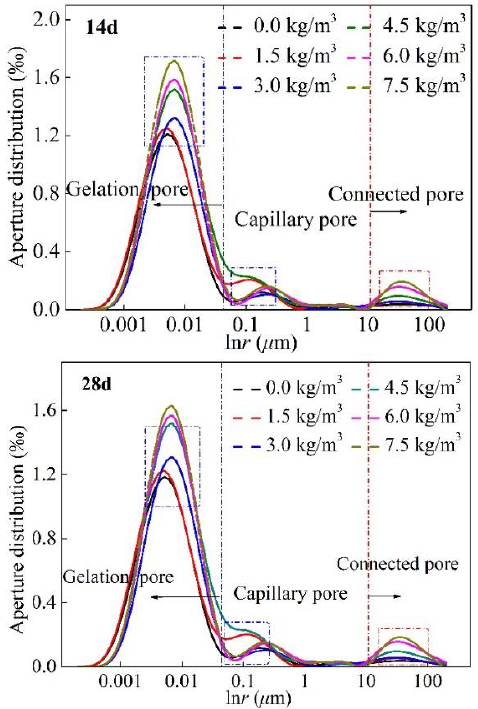
Figure 11. Distribution of different-sized pores in BF concrete (7 d, 14 d, and 28 d).